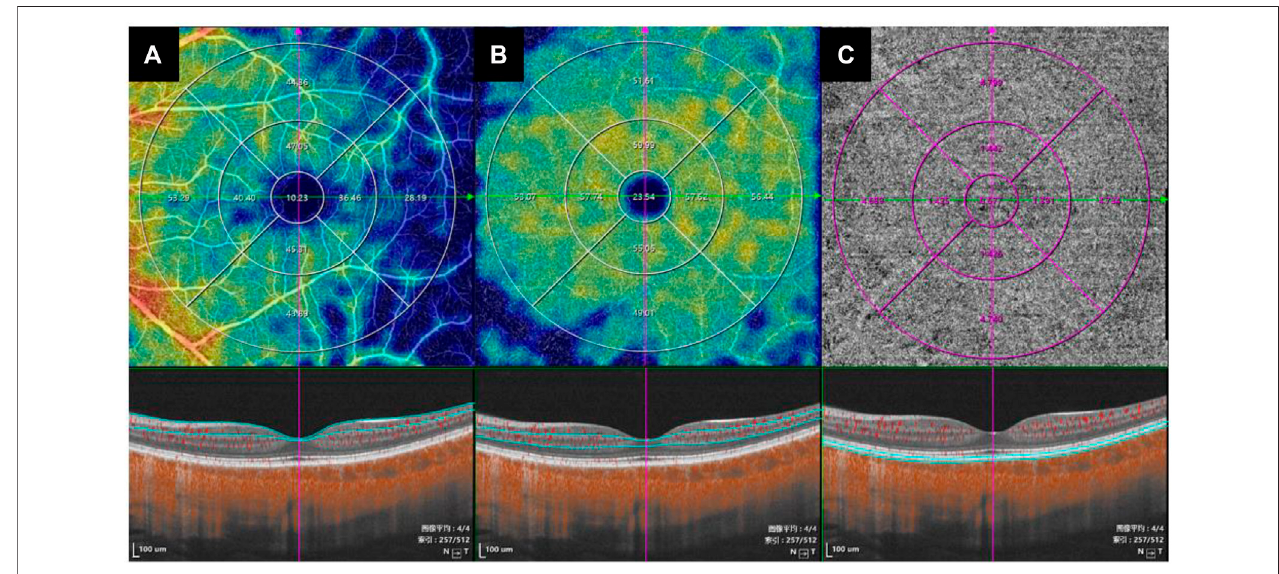
FIGURE 3 | The value of the microcirculation parameters were calculated automatically by the system. The top en-face images are intensity projections of the regionsselectedbythebluelinesinthebottomimages. (A) Theretinalsuper fi cialvascularcomplexwasautomaticallyde fi nedbythesystemasmicrovesselsfound5 μ m above the inner limiting membrane to one-third interface of ganglion cell layer and inner plexiform layer (GCL + IPL). (B) The retinal deep vascular complex was automatically de fi ned by the system as one-third interface of GCL + IPL to 25 μ m below the lower border of the inner nuclear layer. (C) The choriocapillaris was automatically de fi ned by the system as the microvasculature from the basal border of the RPE-Bruch ’ s membrane complex to 20 μ m below it.